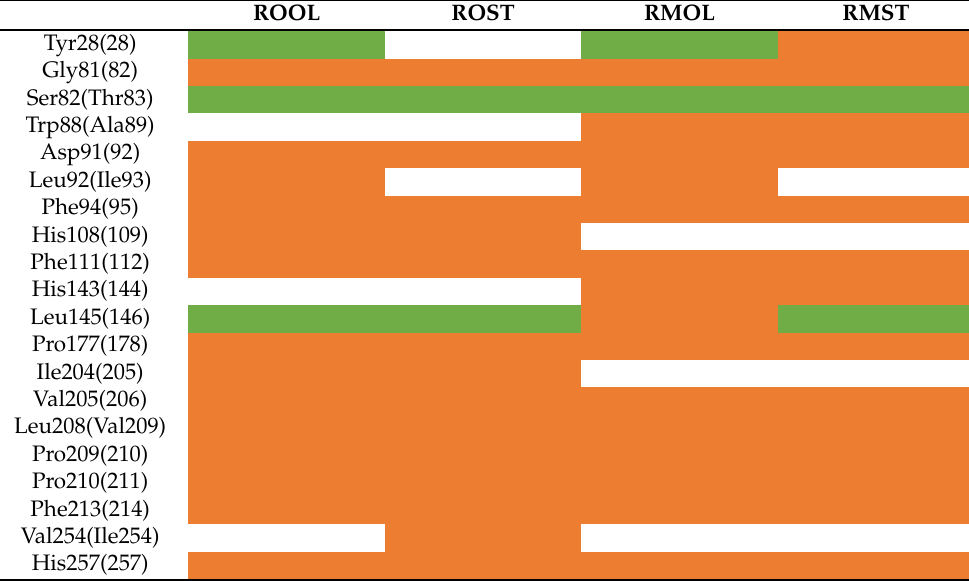
Table 3. Amino acid residues interacting with the ligand in docking complexes. The green cell means that the residue can potentially form a hydrogen bond with the ligand. The orange cell means that the residue formed a hydrophobic interaction with the ligand. The blank cell means that the residue did not interact with the ligand. The residues of ROL are shown followed by the residues of RML in brackets. ROOL ROST RMOL RMST Tyr28(28) Gly81(82)